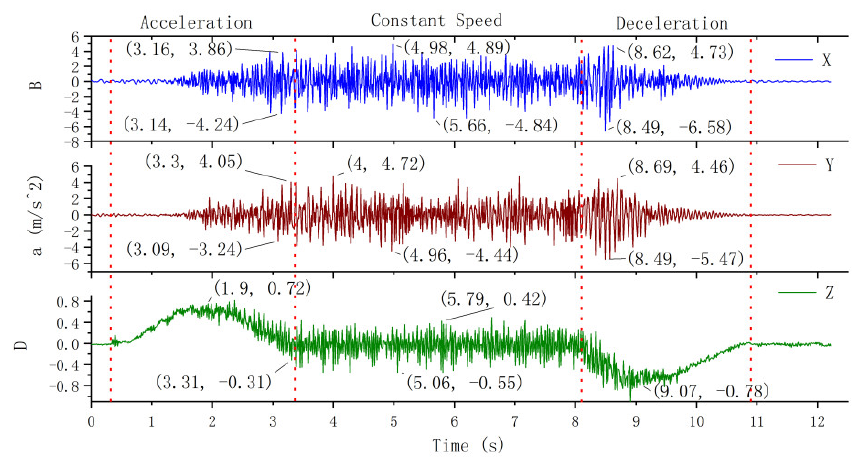
Figure 9. Transverse and longitudinal vibration of hoist rope.